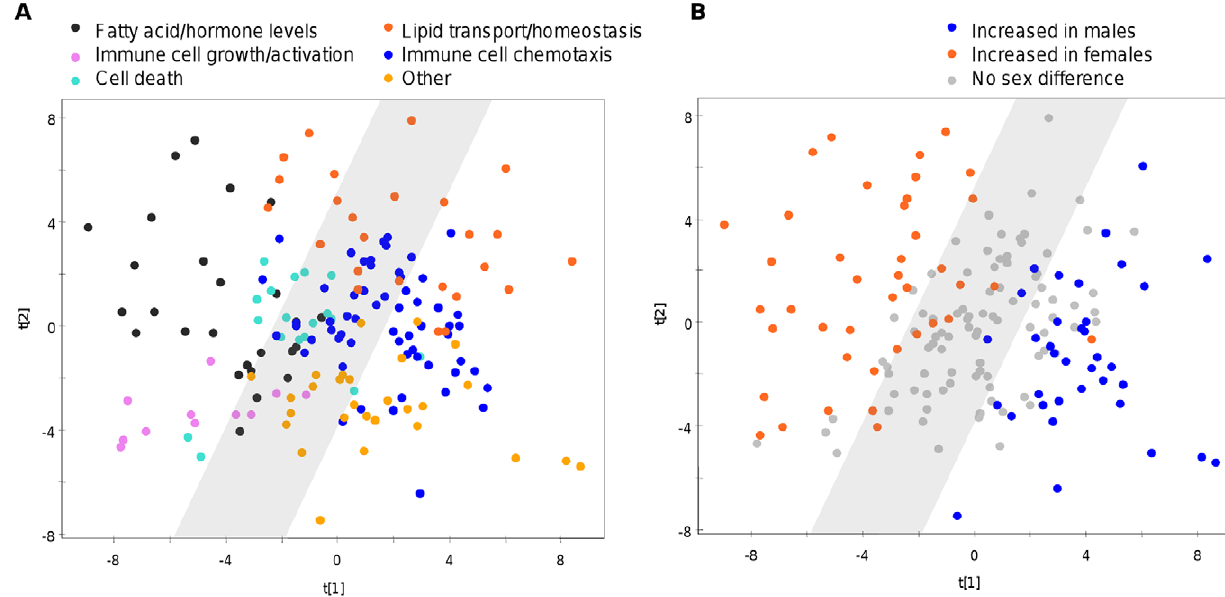
Figure 1. PCA plots showing individual molecules. A) Assignment of analyte clusters to biological functions; B) Sex differences as determined by meta-analysis. Colouring indicates significance (q , 0.05). The grey area indicates analytes that show no significant sex differences. Plots were generated using data from cohort 7, in which 167 analytes were measured in 162 typical controls (81 females, 81 males).